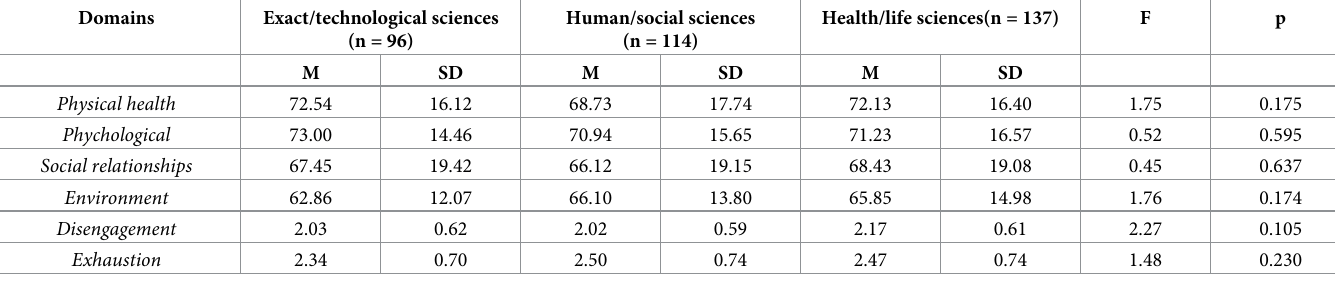
Table 3. Mean scores of quality of life and occupational burnout according to the field of knowledge (n = 347). Domains